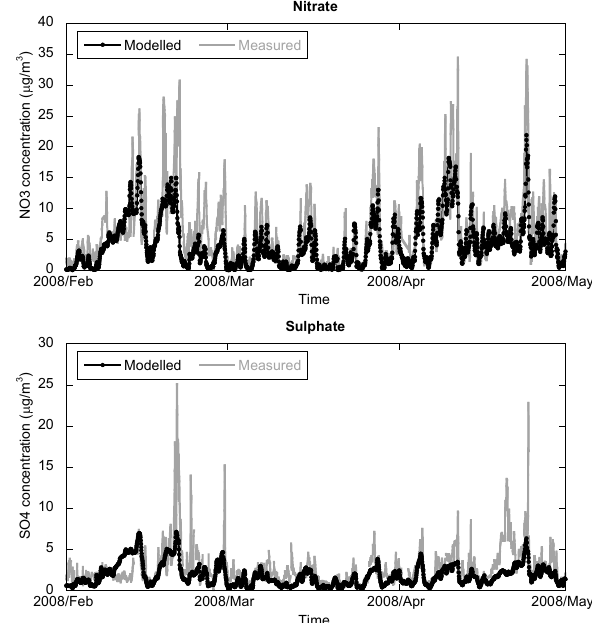
Figure 3. Comparison of the measured (grey) day to day variability for nitrate, sulphate and 2 Fig. 3. Comparison of the measured (grey) day to day variabil- ammonium at Cabauw with 7 km grid resolution estimates (black) of the LOTOS-EUROS 3 ity for nitrate, sulphate and ammonium at Cabauw with 7km grid model for this location and the full year. 4 resolution estimates (black) of the LOTOS-EUROS model for this location and the full year.